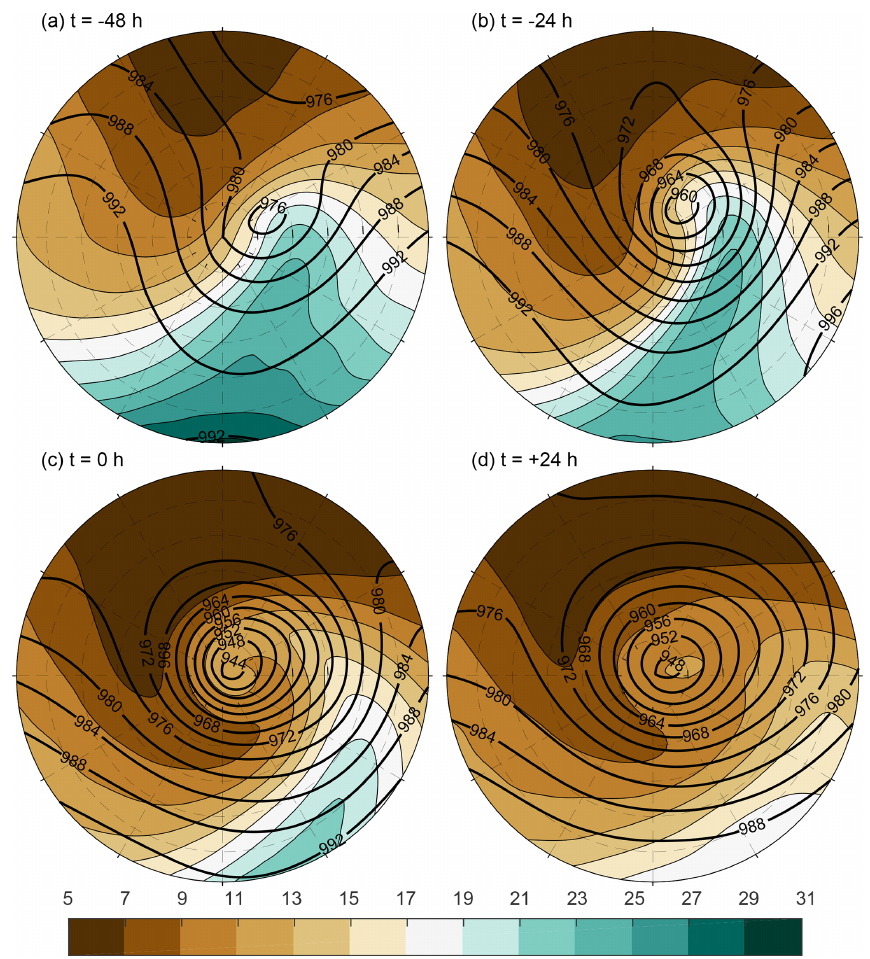
Figure 5. Composite cyclone of the strongest 200 extra-tropical cyclones in the CNTL simulation at (a) 48h before time of maximum vorticity, (b) 24h before time of maximum vorticity, (c) time of maximum vorticity, and (d) 24h after the time of maximum vorticity. Shading shows the total column water vapour (gkg − 1 ), and black contours show the mean sea level pressure (hPa). The plotted radius is 12 ◦